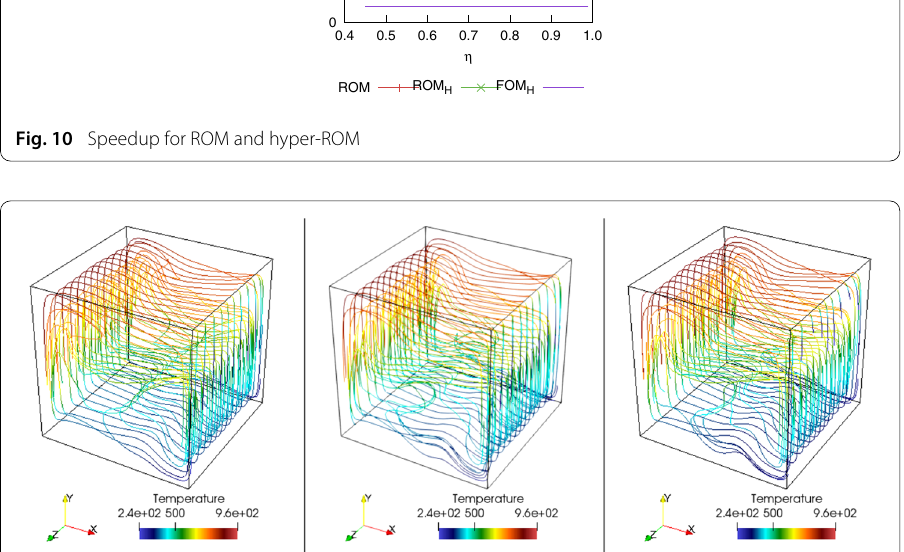
Fig. 11 Streamlines at t = 10 for FOM, ROM and hyper-ROM with η = 0 . 8